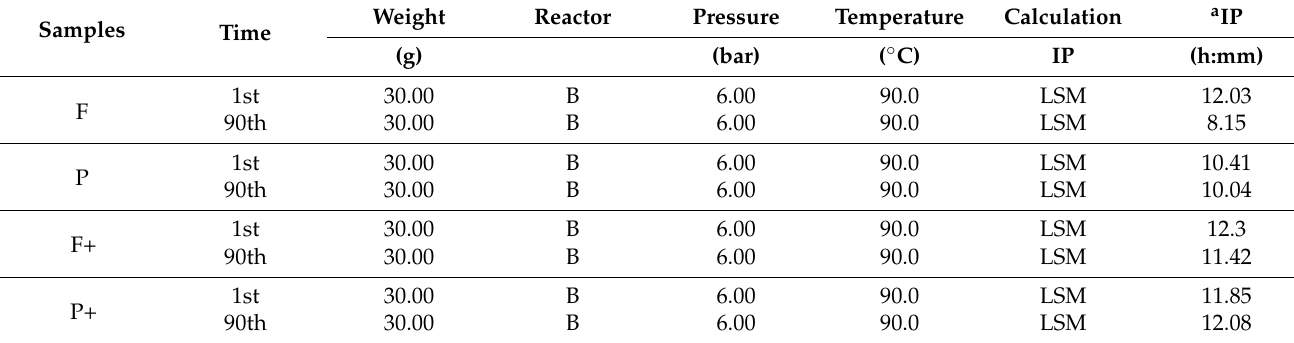
Table 7. Effect of storage time on oxidative stability of pesto